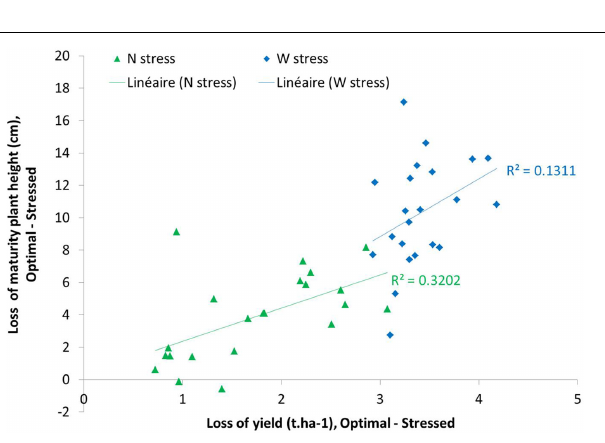
FIGURE 15 | Mean of yield loss related to plant height loss at maturity stage between WW N+ and WW N0 (Nitrogen stress impact in green points) and WD N+ and WD N+ (Water stress impact in blue